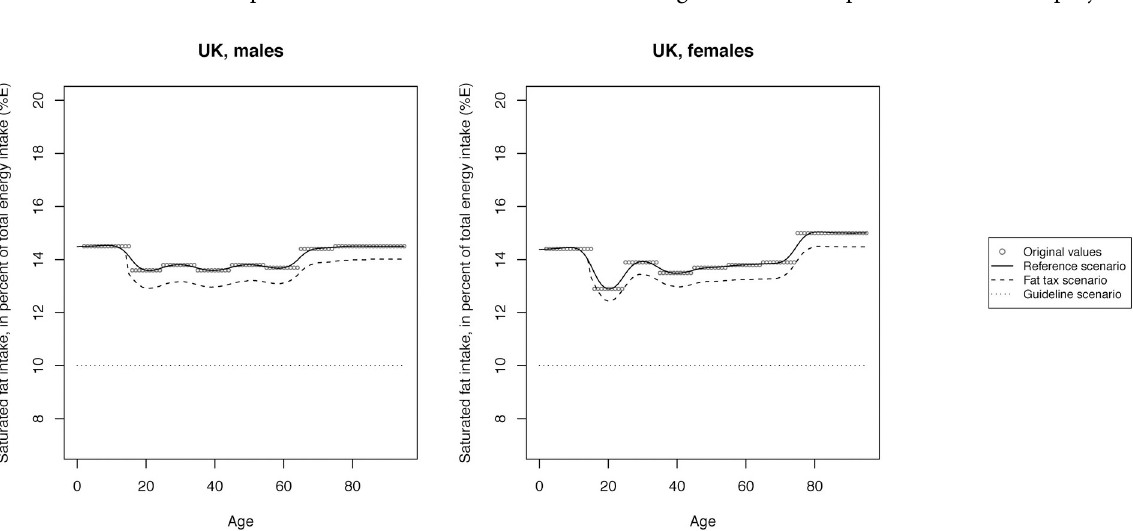
PLOS ONE | https://doi.org/10.1371/journal.pone.0218464 July 10,